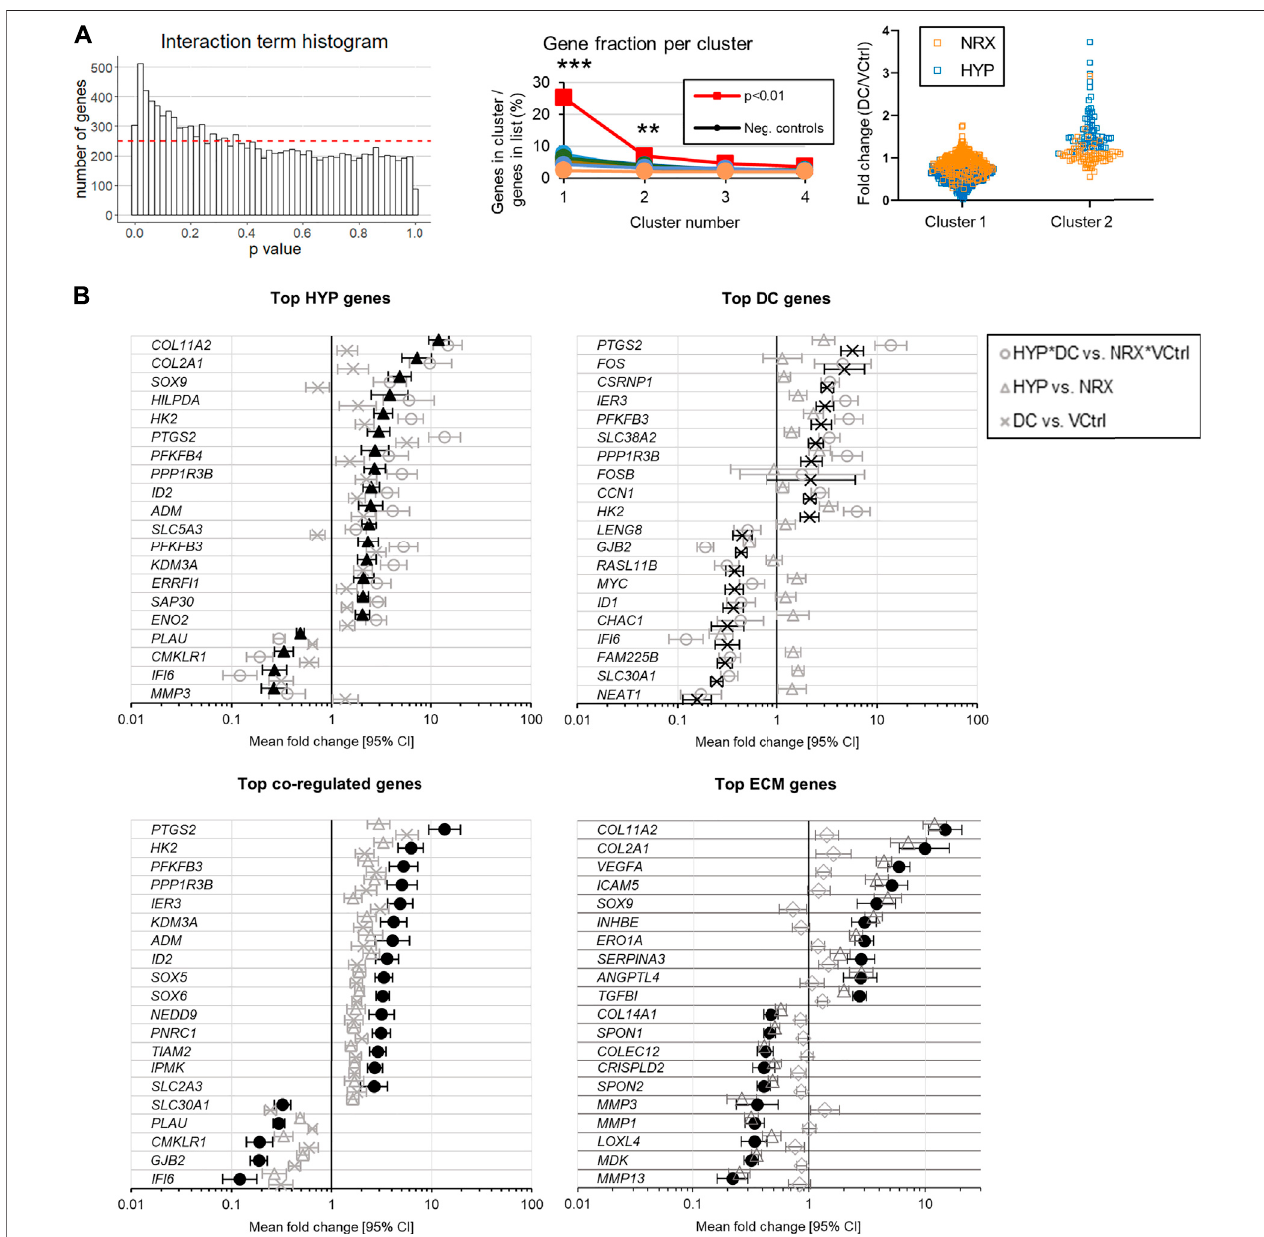
FIGURE 4| Experiment I: (A) Interaction analysis after the 5-days mechano-hypoxia treatment. The dashed red lineindicates the expected bin height for a uniform distribution. (B) Genes with thelargest absolute fold changesfor each group (q < 0.05, total count > 250). Expression wasmeasured 30 min after the fi nal loading event. CI: con fi dence interval. Neg,